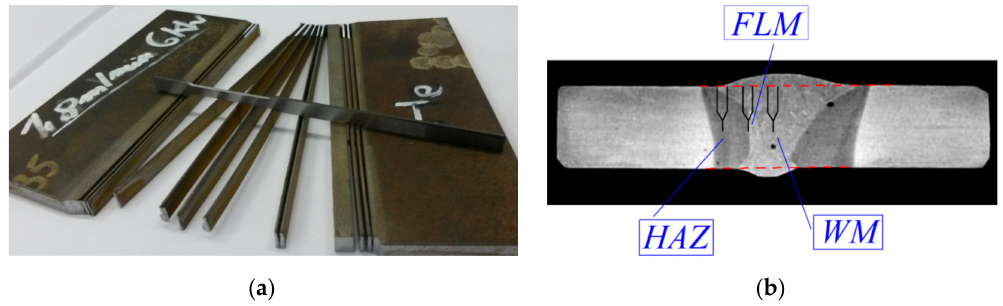
Figure 10. Making the specimens from di ff erent zones of welded joint to conduct tests: ( a ) Uniaxial tensile; ( b ) fracture toughness. Table 2. Mechanical properties of materials from di ff erent zones of the welded